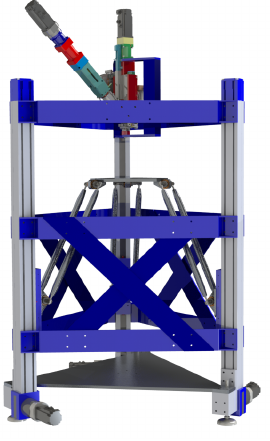
Figure 9. Machine